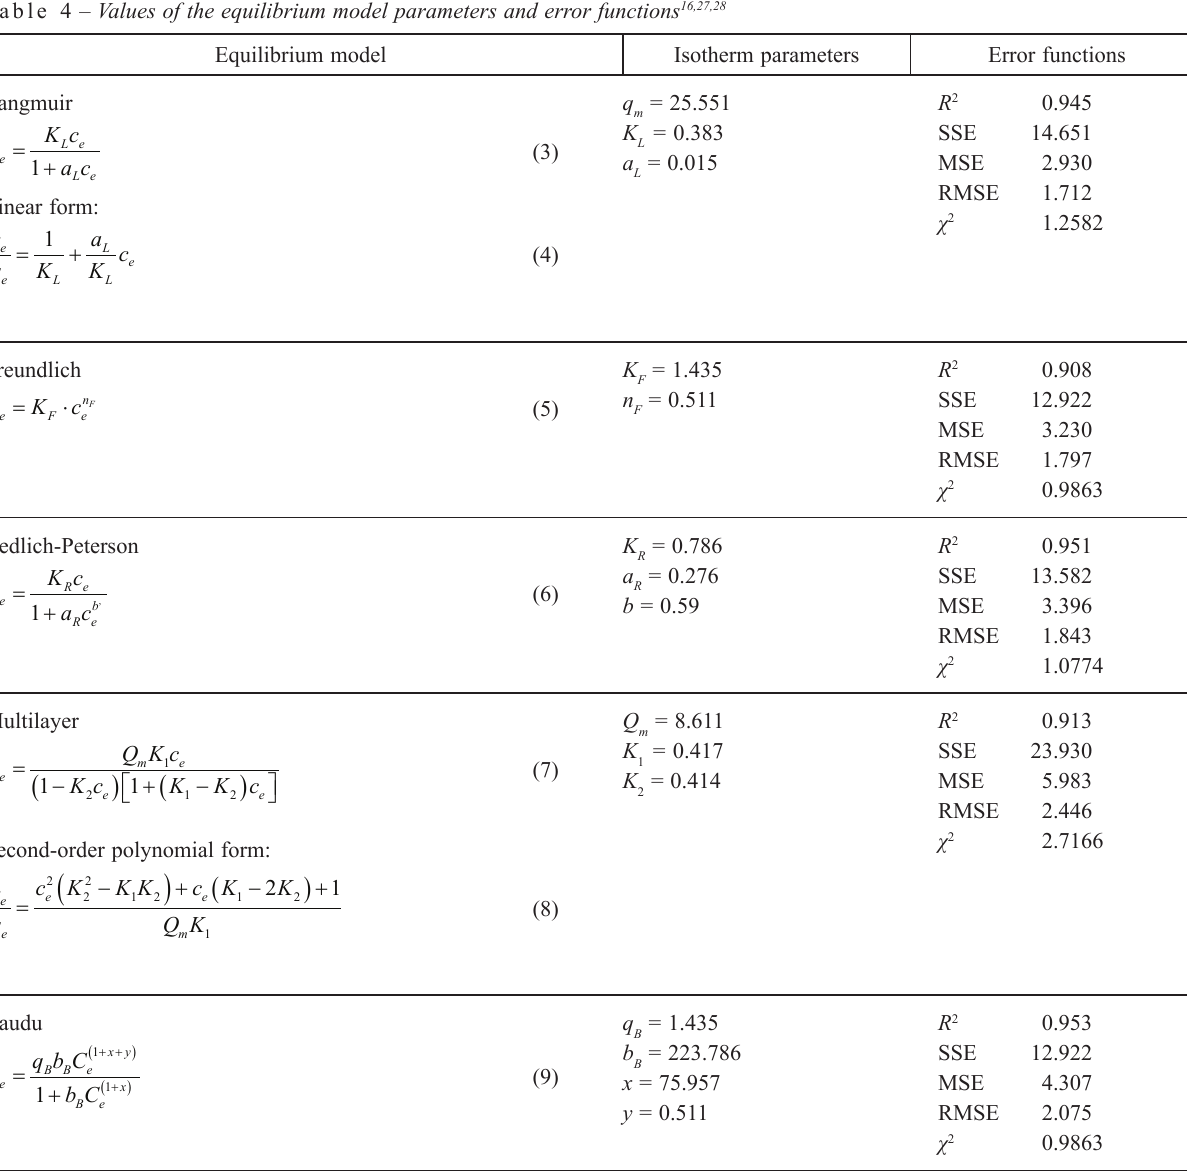
Table 4 – Values of the equilibrium model parameters and error functions 16,27,28